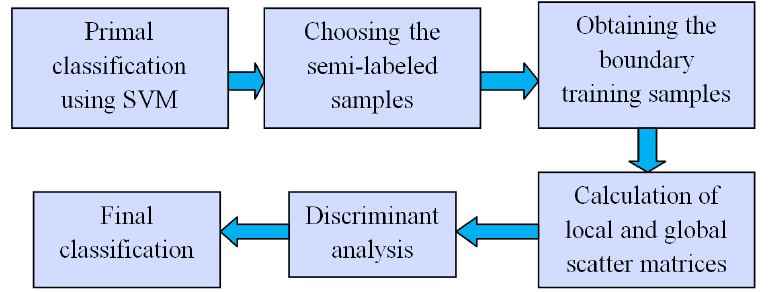
Figure 1. Block diagram of proposed method